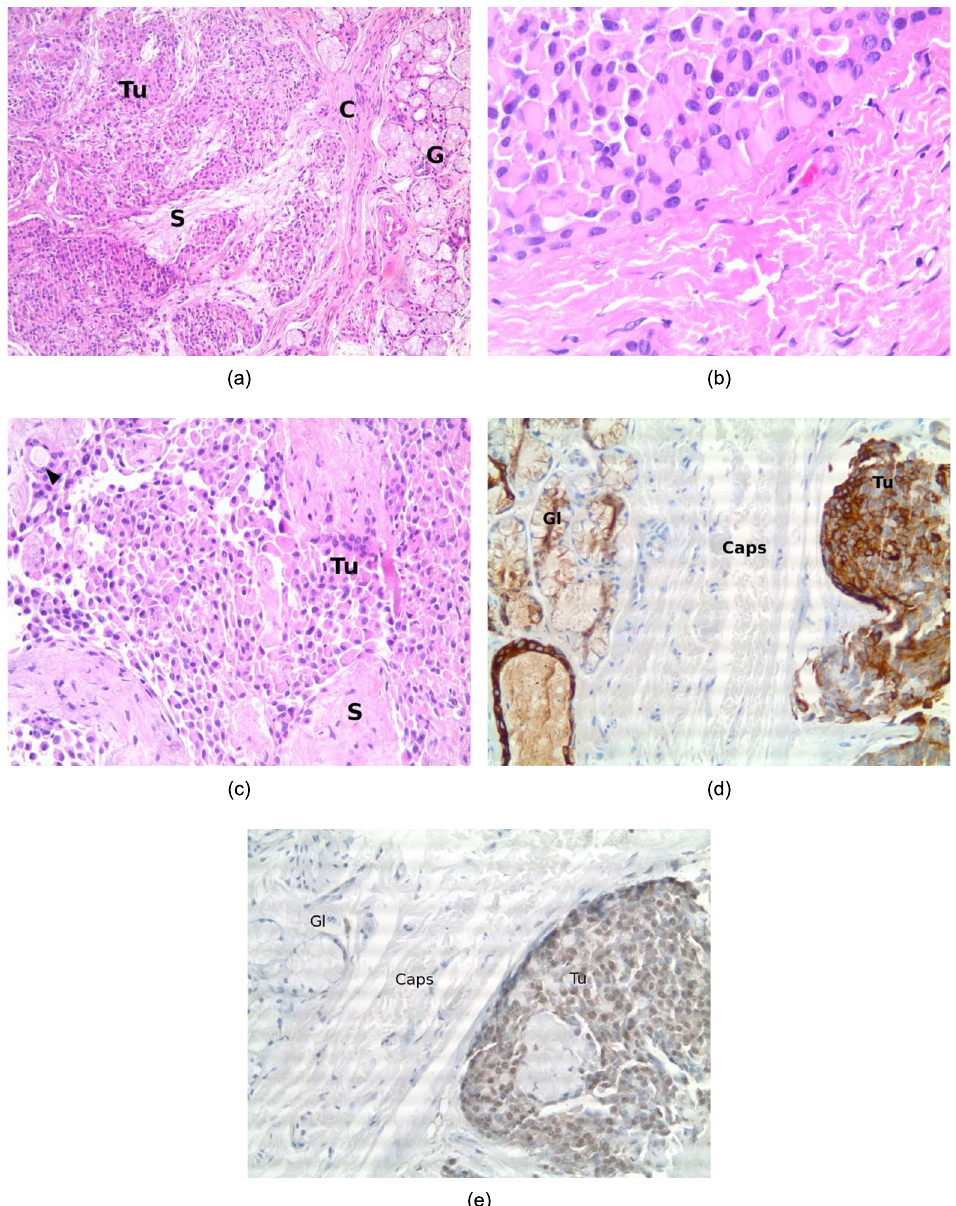
plasmacytoïd epithelial clusters (H&E staining 400 (cid:3) ). C: Histological view showing a rare salivary duct (black arrow) within the tumoral mass. D: Immunostaining positive for cytokeratin AE1 – AE3 (healthy gland on the left, (cid:3) 200). E: Immunostaining positive for PS-100 (healthy gland on the left, (cid:3) 400). Tu: tumor; S: Stroma; G: healthy Gland; C or Caps: